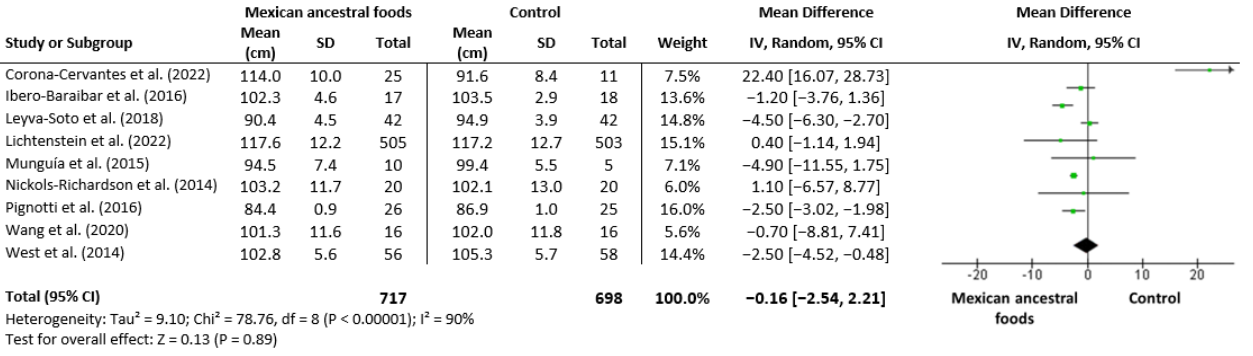
Figure 4. Effect of Mexican ancestral foods supplementation on ( A ) Body weight [30,31,36,38,39,43] ( B ) Body mass index [31,32,34–36,38,40–43] and ( C ) Waist circumference [31,32,34–36,38,40,42,43]. All data are presented as mean ± standard deviation and confidence interval is 95% (CI). Study weights were assigned using the inverse variance method and random-effects model. The diamond ( ) represents the overall effect estimate of the meta-analysis and the green point ( ) represents mean difference of effect measure of each study.